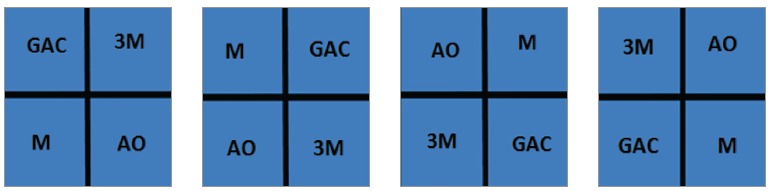
Random distribution by quadrant: M = MorelliTM, GAC = GACTM, AO = American OrthodonticsTM, 3M = 3M UnitekTM.